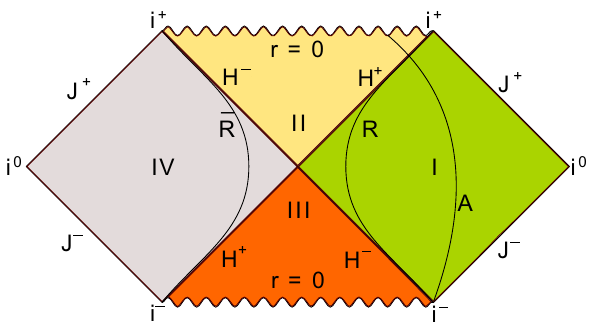
Fig. 2 Penrose diagram for maximally extended black hole which shows the world-line of Alice, Rob and Anti-Rob. i 0 denotes the spa- tial infinities, i − ( i + ) denotes timelike past (future) infinity. J − ( J + ) denotes lightlike past (future) infinity. H ± denote the event horizons of the black